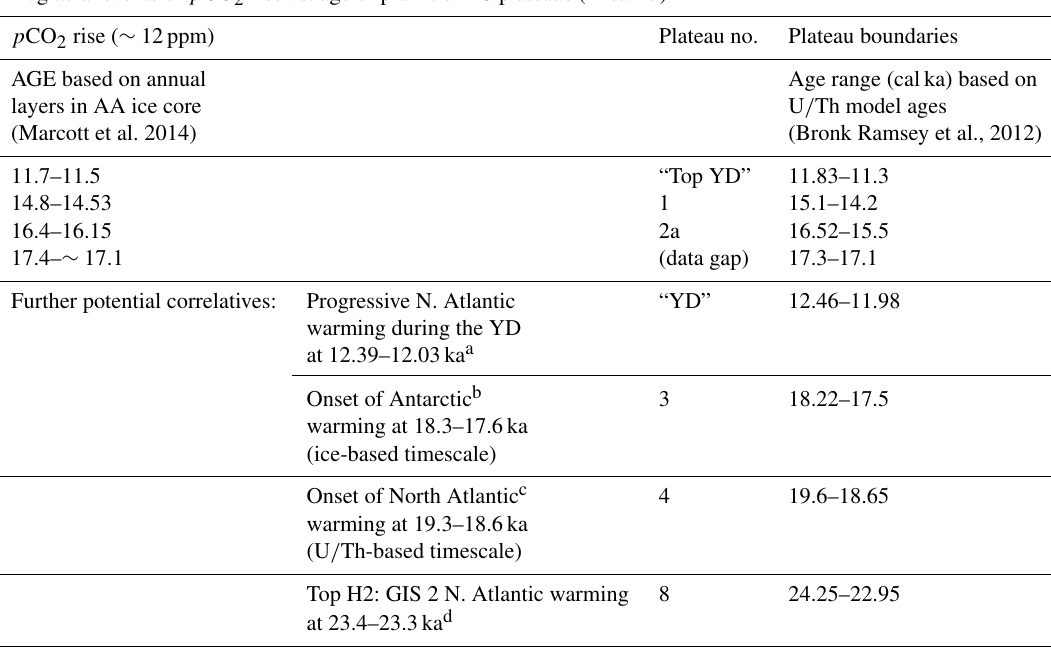
Table 2. Temporal match of various 14 C plateaus with deglacial periods of major atmospheric CO 2 rise and ocean warmings (AA stands for Antarctic, and GIS stands for Greenland Interstadial). Deglacial events of p CO 2 rise vs. age of planktic 14 C plateaus (in calka) p CO 2 rise ( ∼ 12ppm) Plateau no. Plateau boundaries